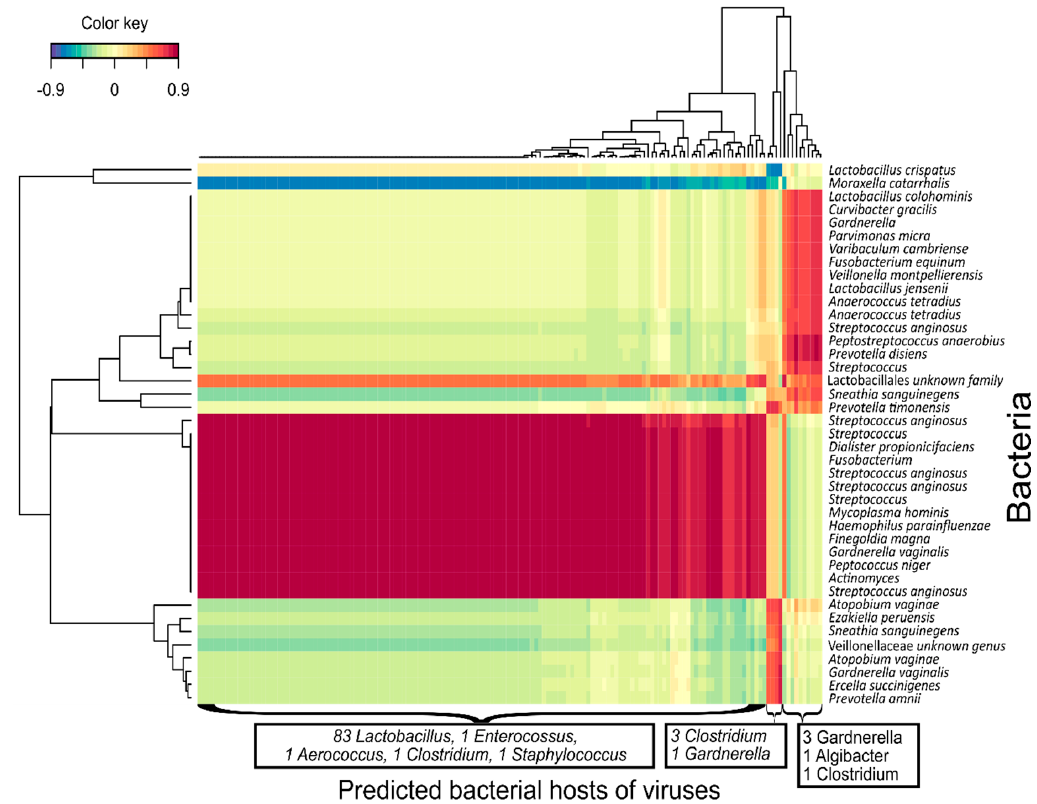
Figure 3. Abundance of phages with beneficial hosts correlated negatively with an abundance of pathogenic bacteria and vice versa. The clustered image map (CIM) of regularized canonical correlation analysis (rCCA) between the relative abundances of bacterial and viral operational taxonomic units (vOTUs). The colour grade shows the strength of correlation between individual bacterial and viral OTUs. Viral clusters were summarized based on their bacterial host genus as predicted by WISH as only a minority had matches in the viral databases. Bacterial OTUs with several entries had distinct 16S sequences and were possibly different strains. Correlations above 0.7 are shown. CV-score =